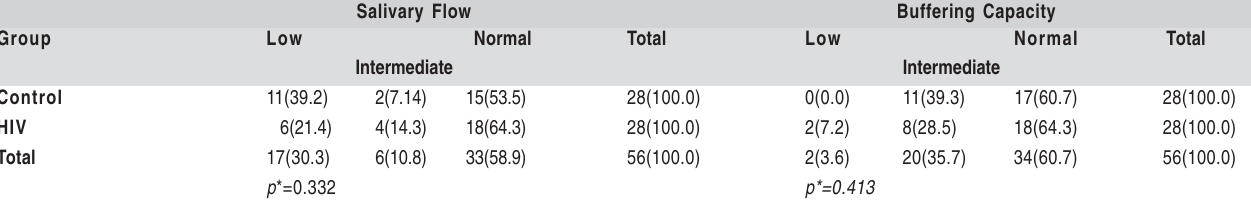
Table 1- Distribution of frequencies of Salivary Flow Rate and Buffering